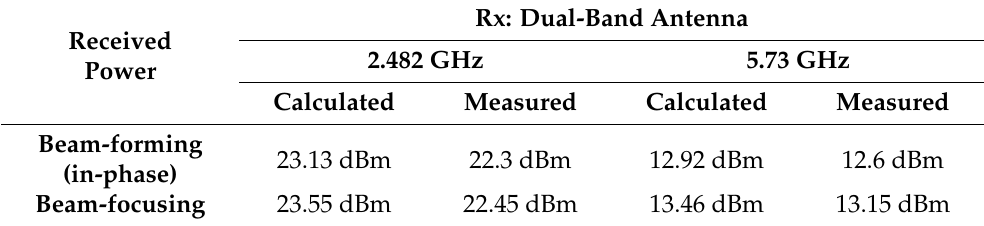
Table 4. Experimental results of the received power when transmitting dual-band power to a dual-band Rx antenna.